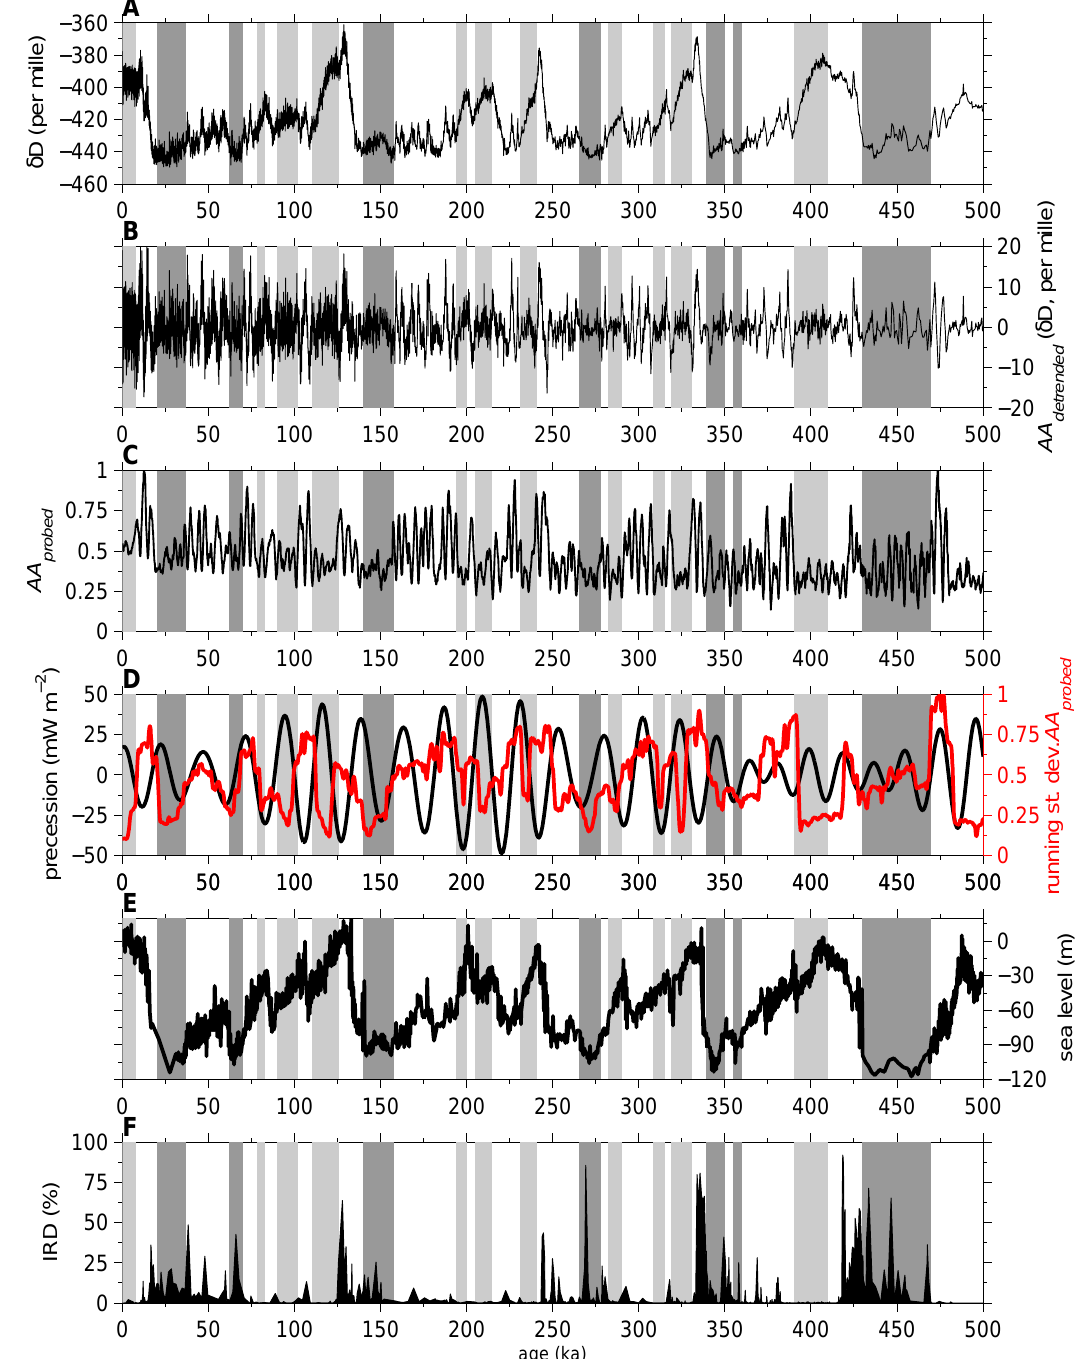
Fig. 1. Data and results discussed in the text (see text for full details). (A) EPICA Dome C deuterium data (EPICA Community members 2004) on the EDC3 time scale. (B) AA detrended , which is the EPICA Dome C deuterium data with the trend removed across 6kyr windows. (C) AA probed , which is the standard residual between AA detrended and A mean normalised to the maximum value over the last 500kyr. Periods with alternating high and low values represent periods of millennial variability similar to A mean . (D) The standard deviation of AA probed over 8kyr windows overlapped by 0.1kyr. High values show periods of intense millennial variability similar to A 2 smooth , low values show periods with little or no millennial variability. Also shown is precession forcing from Berger and Loutre (1991). (E) Red Sea sea-level record from Rohling et al. (2009). (F) IRD from ODP 980 (Oppo et al., 1998; McManus et al., 1999). Light grey bars represent periods of sustained ice sheet growth and the absence of millennial variability and dark grey bars represent periods with ice volume greater than 80m sea-level